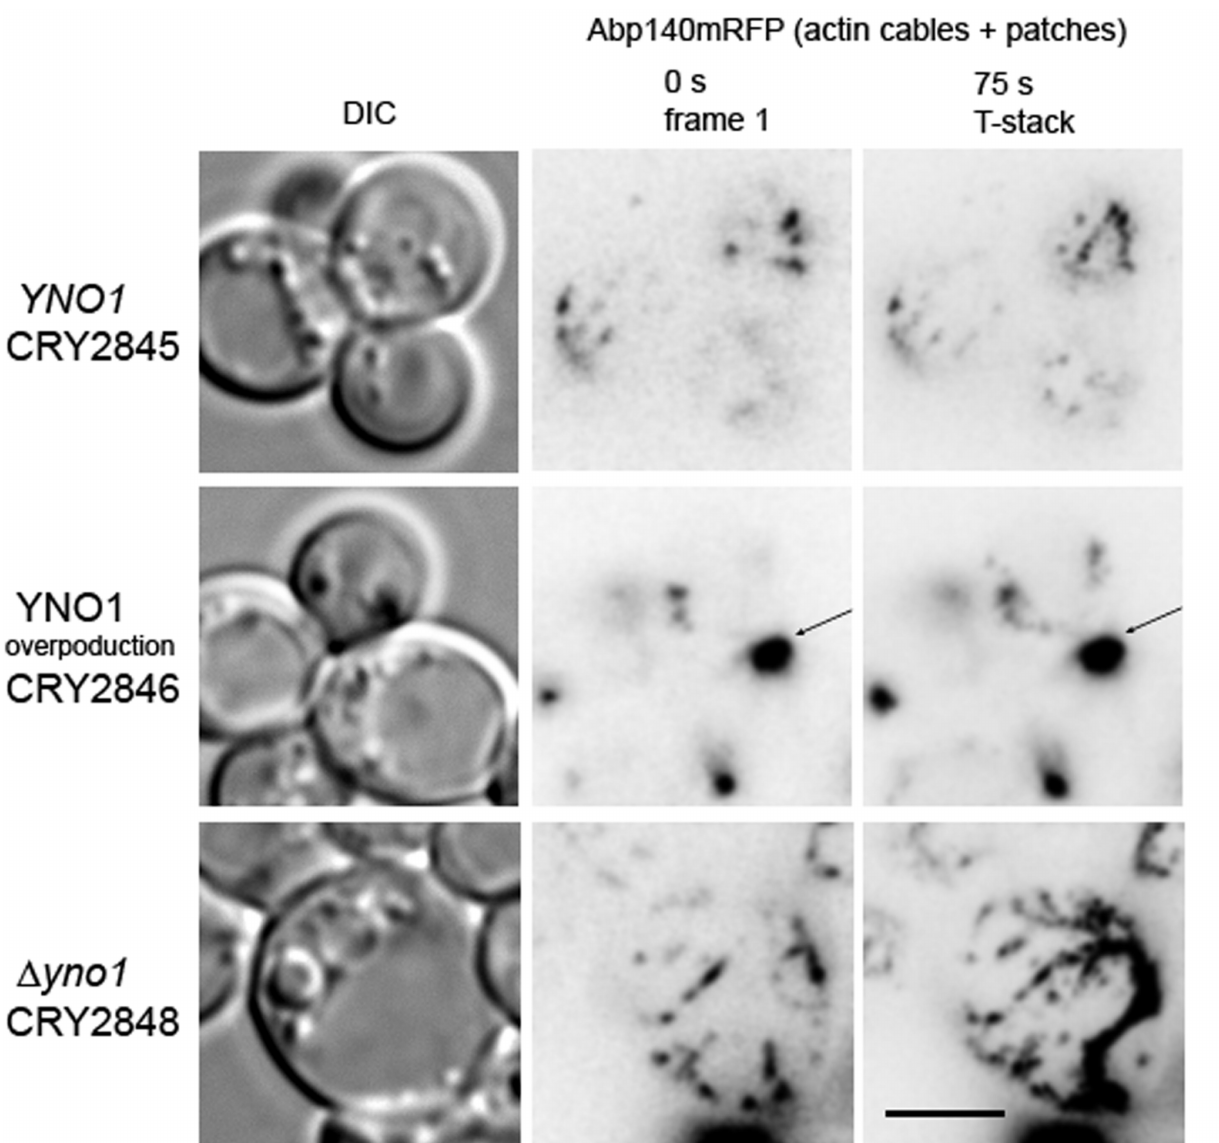
Figure 9. The effect of Yno1p on F-actin distribution at the cell cortex. F-actin structures were visualized by expression from an Abp140-mRFP fusion protein that is integrated into the chromosome. The strains CRY 2845 (MATa SY3089 ste4 FUS1-lacZ FUS1-HIS3 ura3-52; pYES ABP140-RFP-T rho0), CRY 2846 (MATa SY3089 ste4 FUS1-lacZ FUS1-HIS3 ura3-52; pYES YNO1 ABP140-RFP-T rho0), and CRY 2848 (MATa SY3089 ste4 FUS1-lacZ FUS1-HIS3 ura3-52; yno1::KIURA3 ABP140-RFP-T rho-) were grown in synthetic SC-Ura medium and analyzed after addition of 3% galactose for 7 h. Dynamics of F-actin structures was expressed as a T-stack (superposition of 15 images of the cortical F-actin taken in 5 sec intervals). For each strain at least 3 biological and more than 100 cells were inspected. In the strain CRY2845 small actin patches were observed, whereas in the strain CRY2848 there was a prevalence for cortical actin cables. In strain CRY2846, static F-actin bodies of large size are frequently formed (arrow). Bar, 5 µ